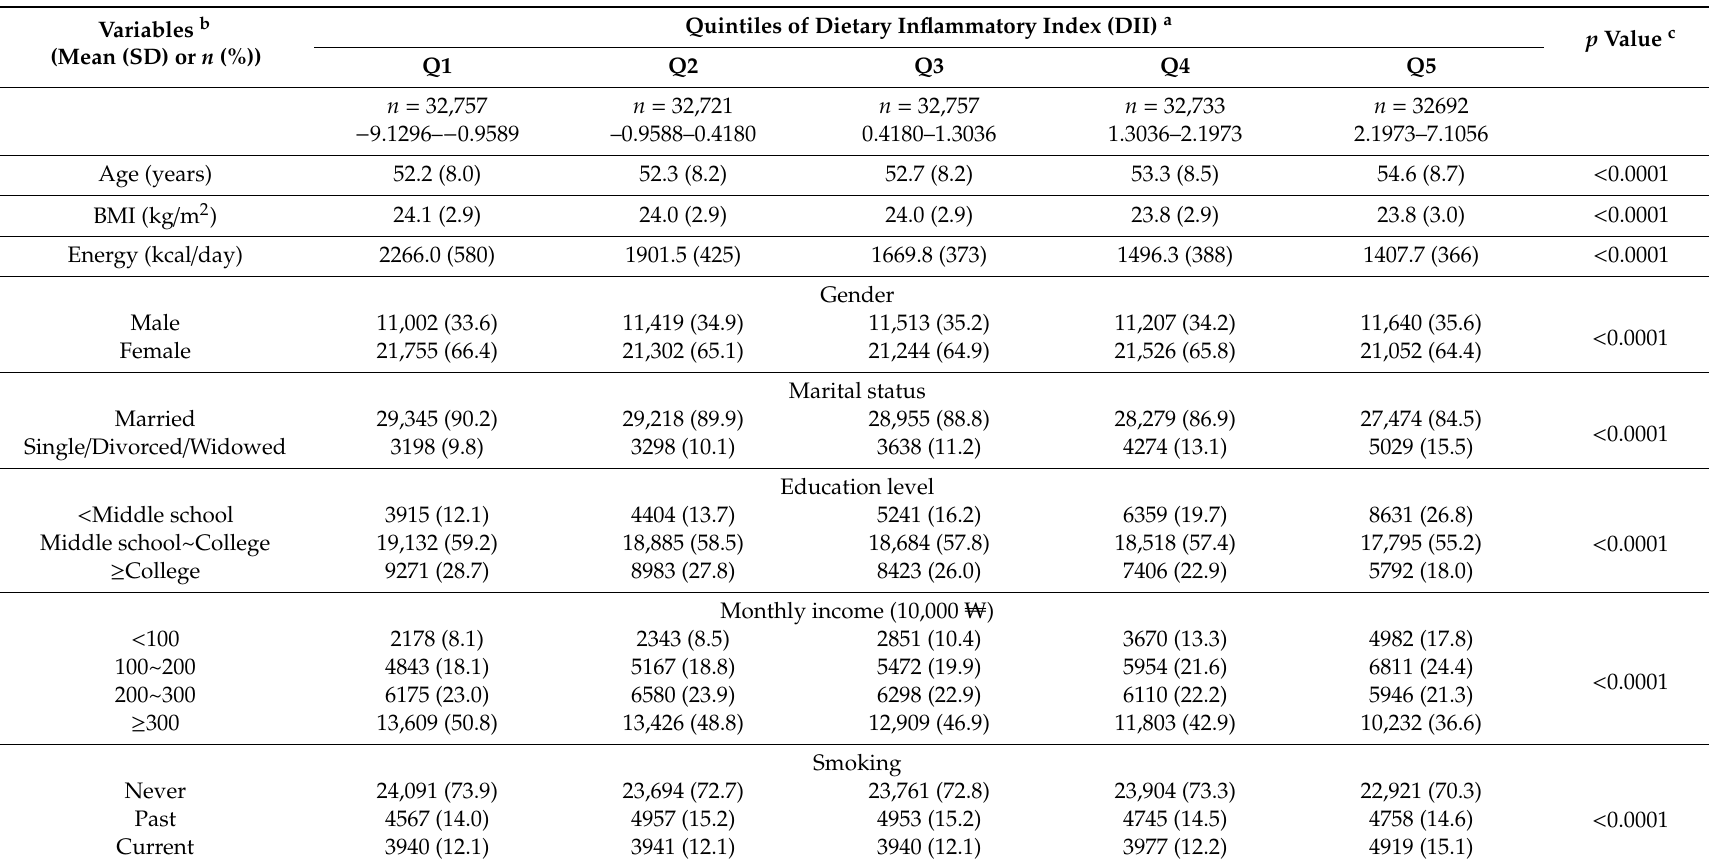
Table 1. Selected variables at baseline according to Dietary Inflammatory Index (DII), KoGES